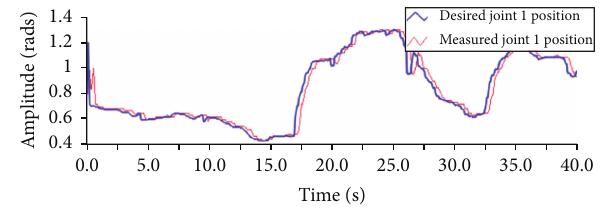
Figure 15: Desired and measured joint 1 position.